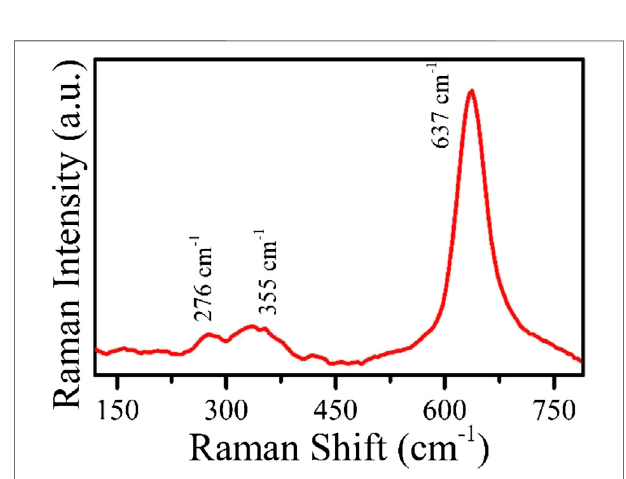
FIGURE 3 | Raman spectrum of MnO 2 nps recorded at room temperature (25 °